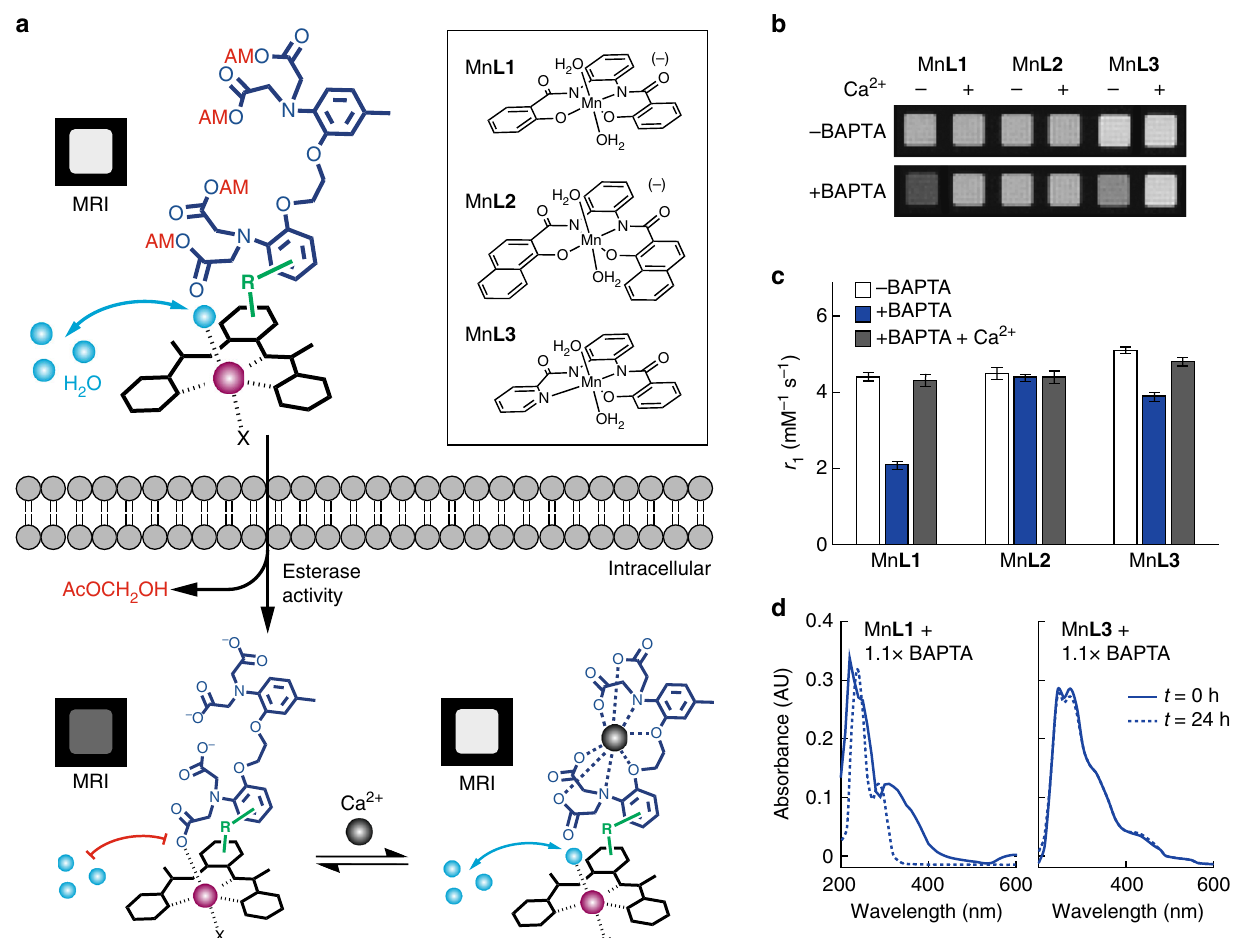
Fig. 1 Design of cell permeable sensors for calcium-dependent molecular fMRI. a The design consists of a cell permeable paramagnetic platform (black complex, Mn-PDA candidate complexes shown at top right), a BAPTA-based calcium chelator (dark blue), and a linker connecting them (green, R). Prior to cell entry (top) the BAPTA carboxylates are protected with cleavable AM esters (red), and water exchange (cyan spheres) is expected to take place at the paramagnetic metal center (purple), leading to T 1 -weighted MRI signal enhancement (labeled MRI). When the agent enters cells (bottom left), the AM esters are cleaved, liberating the sensor in its calcium-free “ off ” state; in this state, water exchange is expected to be blocked by interactions between the BAPTA moiety and Mn 3 + , leading to low MRI signal. When calcium binds (bottom right), the MRI signal could increase again as interactions between the BAPTA and paramagnetic platform are reduced. b Evaluation of interactions between untethered BAPTA and Mn-PDA contrast agents. In the absence of BAPTA, the Mn 3 + complexes (40 µ M) do not produce calcium-dependent T 1 -weighted MRI contrast changes (top), but in the presence of 1.1 equiv BAPTA, both Mn L1 and Mn L3 display sensitivity to addition of 1 mM calcium (bottom). c Longitudinal relaxivity ( r 1 ) values corresponding to the conditions in panel b . Error bars denote SD of four measurements. d Optical spectra of contrast agents Mn L1 and Mn L3 in the presence of BAPTA after incubation for 0 h (solid) or 24 h (dashed), indicating comparative stability of Mn